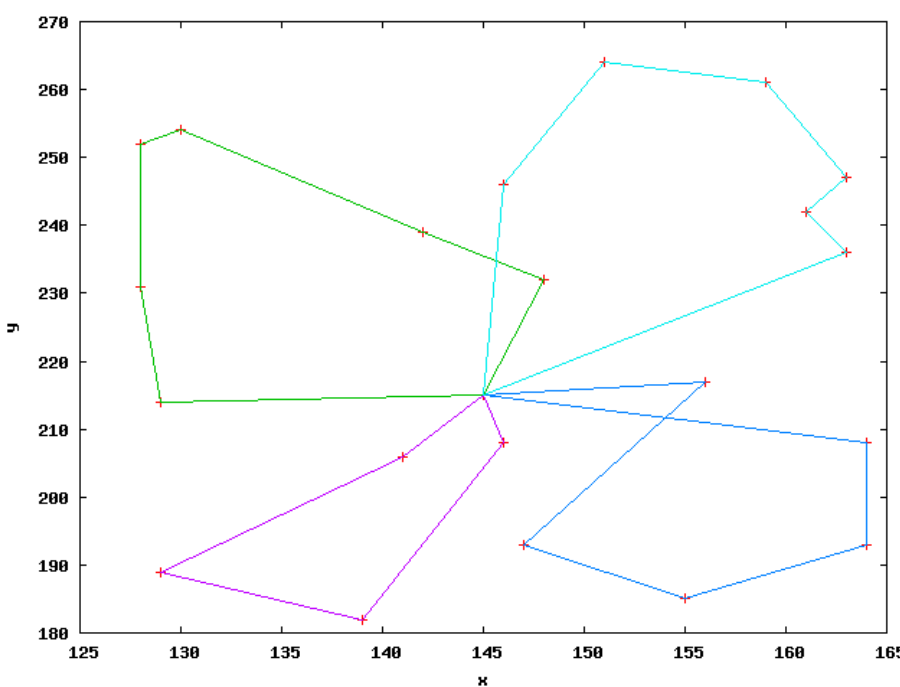
Figure 8. All combinations, moderate settings, fast experiment—example with fitness distance from the best-known one around